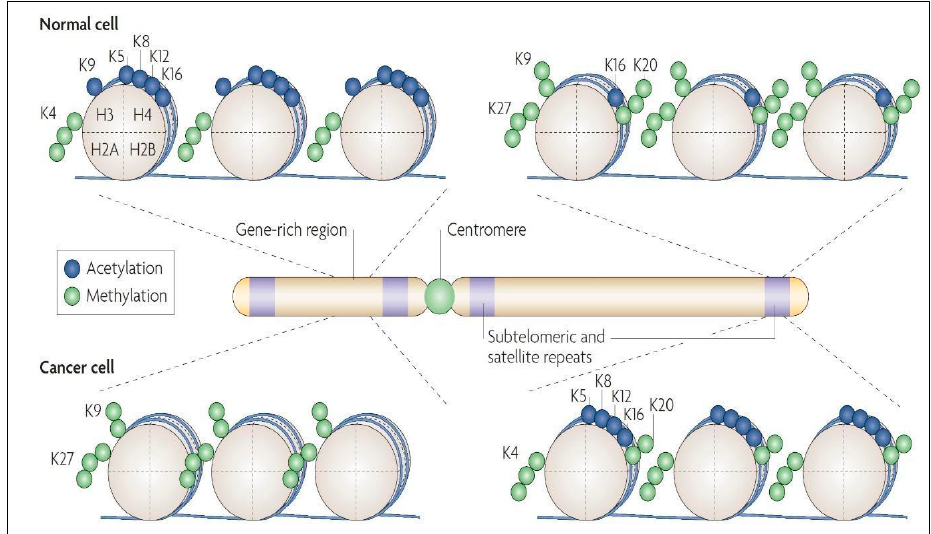
Figure 6. Histone modification maps for a typical chromosome in normal and cancer cells. In normal cells, DNA sequences that include the promoters of tumor-suppressor genes have more histone modification marks associated with active transcription, such as acetylation of H3 and H4 lysine residues (e.g., K5, K8, K9, K12, and K16) along with trimethylation of K4 residue of H3 protein. The normal cell also has DNA repeats and other heterochromatic regions having repressive histone marks, such as trimethylation of K27 residue and dimethylation of the K9 residue of H3, and tri- methylation of K20 of H4. In cancer cells, there is a loss of the “active” histone marks on promoters of tumor-suppressor genes, leading to a tighter chromatin configuration. Additionally, the neo- plastic cell has a loss of repressive marks at subtelomeric DNA and other repeat regions, causing a more “relaxed” chromatin conformation in these regions. Figure reproduced with permission from [28].